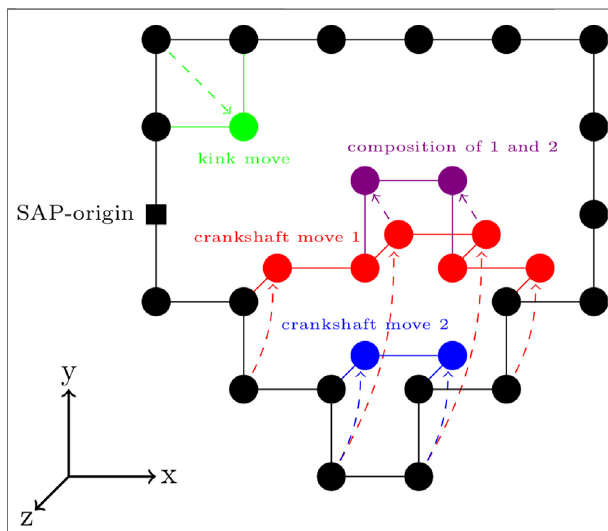
FIGURE4| Circularity-preservingmovesonacubiclattice — Anexample kinkmoveisshowningreen.Twoexamplecrankshaftmovesareshowninred and blue. Following a single enumeration of the set of possible crankshaft moves, multiple crankshaft moves can be made, provided that they are compatible with the crankshaft moves previously sampled from that set of possiblecrankshaftmoves.Anexampleofthisisshownbythecompositionof crankshaft moves 1 and 2 in the